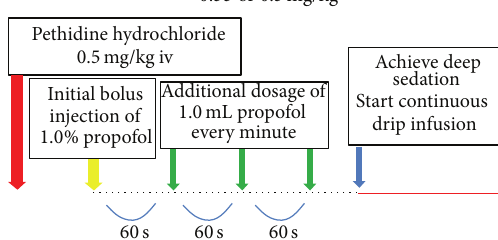
Figure 1: Introduction of sedation: (1) bolus injection of pethidine hydrochloride (0.5 mg/kg) was administered; (2) initial dose of 1.0% propofol was administered; (3) 1.0mL of propofol was added every min until anesthesia to level 6 on the Ramsey Sedation Scale (patient exhibits no response) was